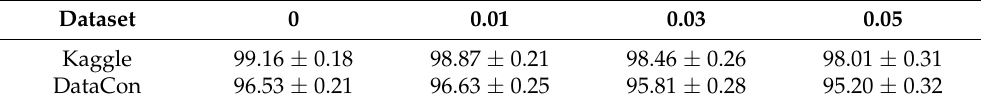
Table 4. Detection accuracy under the influence of different noise